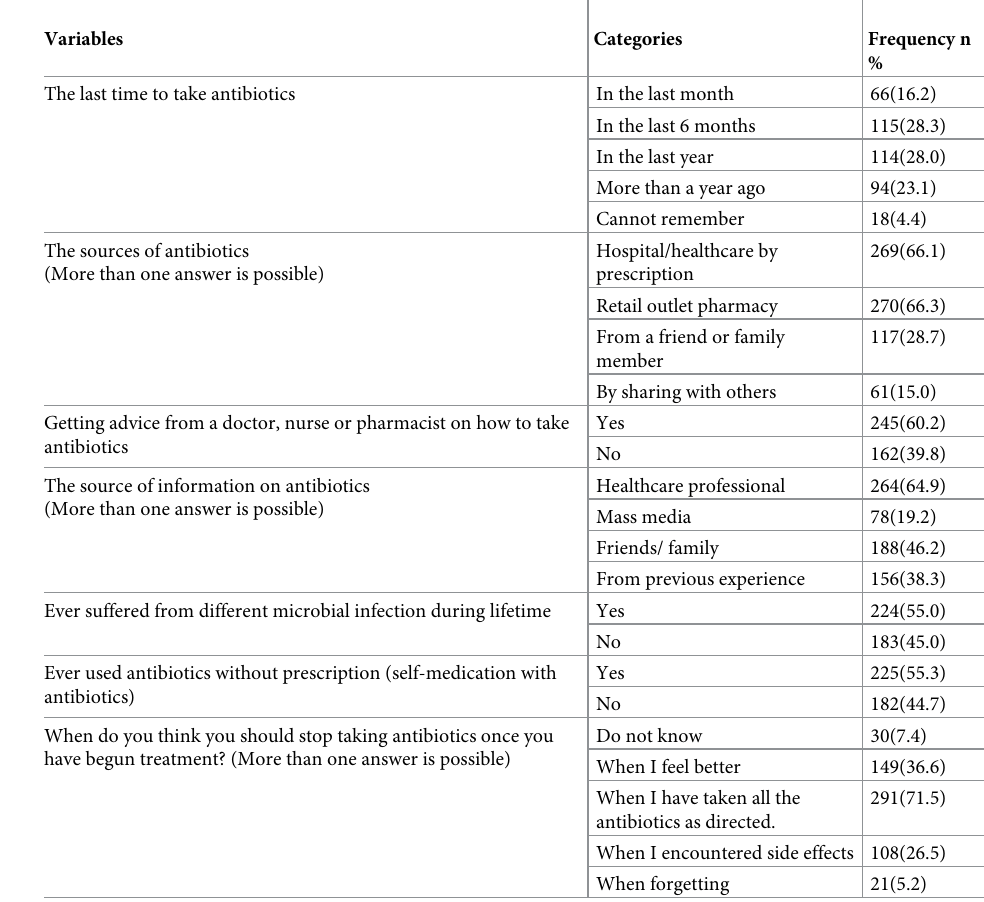
Table 2. Antibiotic use and related information among the adults of Dessie City, Northeast Ethiopia, 2021 (n = 407).